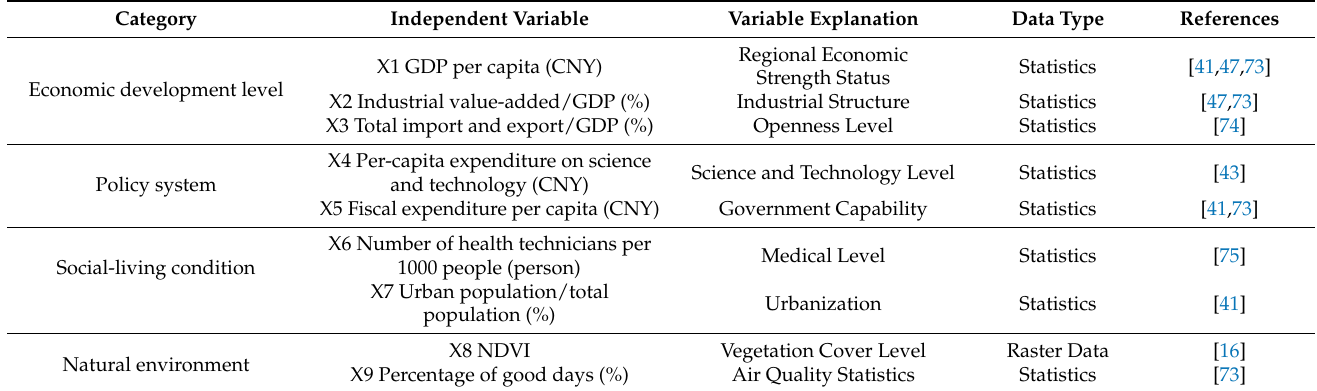
Table 6. Influencing factors index system.